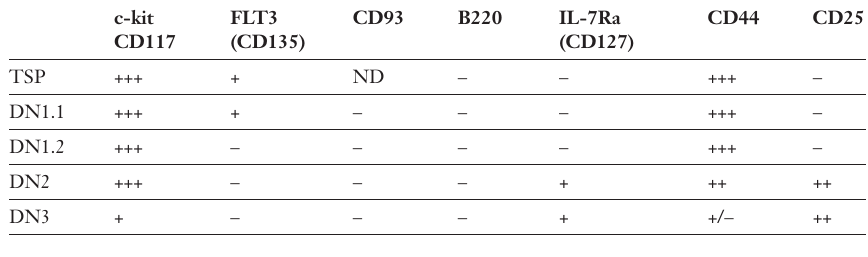
Developmental potential of early